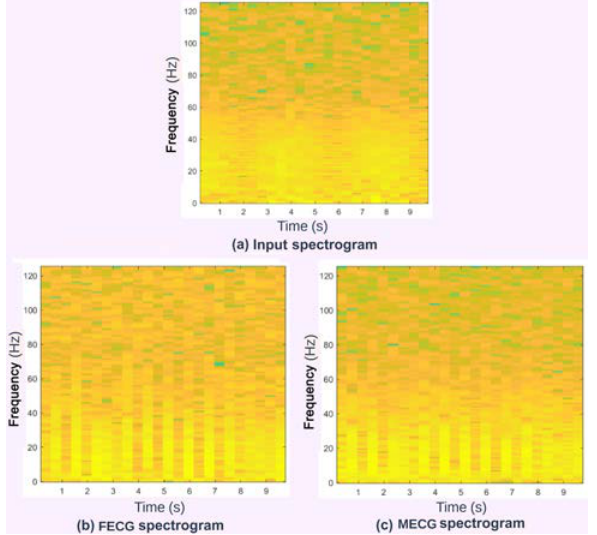
Fig. 17 FECG and MECG